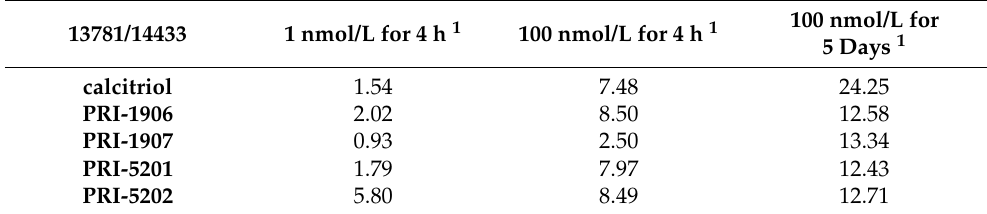
Table 1. Increase in CYP24A1 expression in the 13781 cells relative to the expression increase in the 14433 cells.